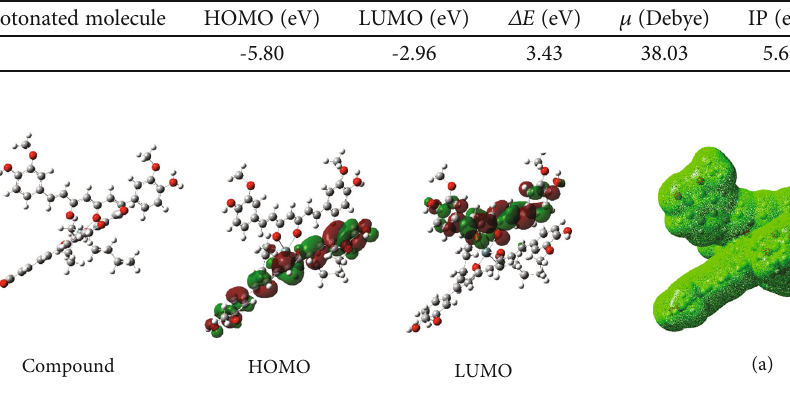
Figure 12: Optimized molecular structure of protonated SnX molecule and HOMO and LUMO orbitals of the Sn-metallic complex, SnX molecule. Atomic colours represent gray (C), white (H), red (O), blue (N), and dark-blue-square (Sn).